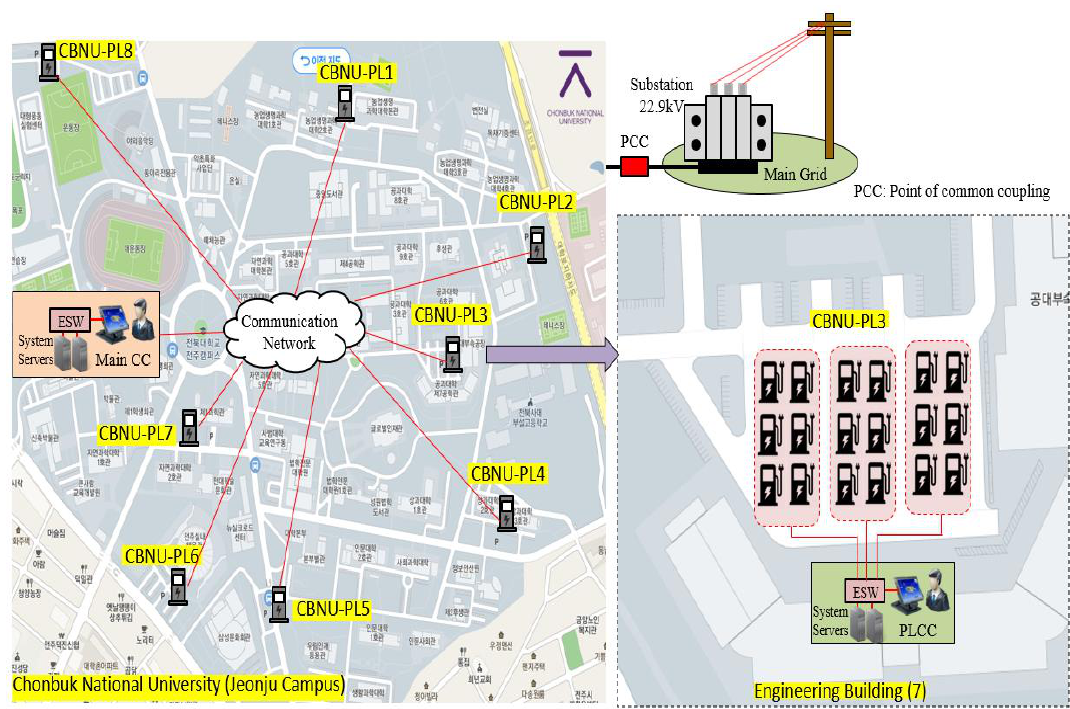
Appl. Sci. 2018 , 8 , x FOR PEER REVIEW Figure 4. Campus parking lots at Chonbuk National University, Jeonju Campus, South Korea.